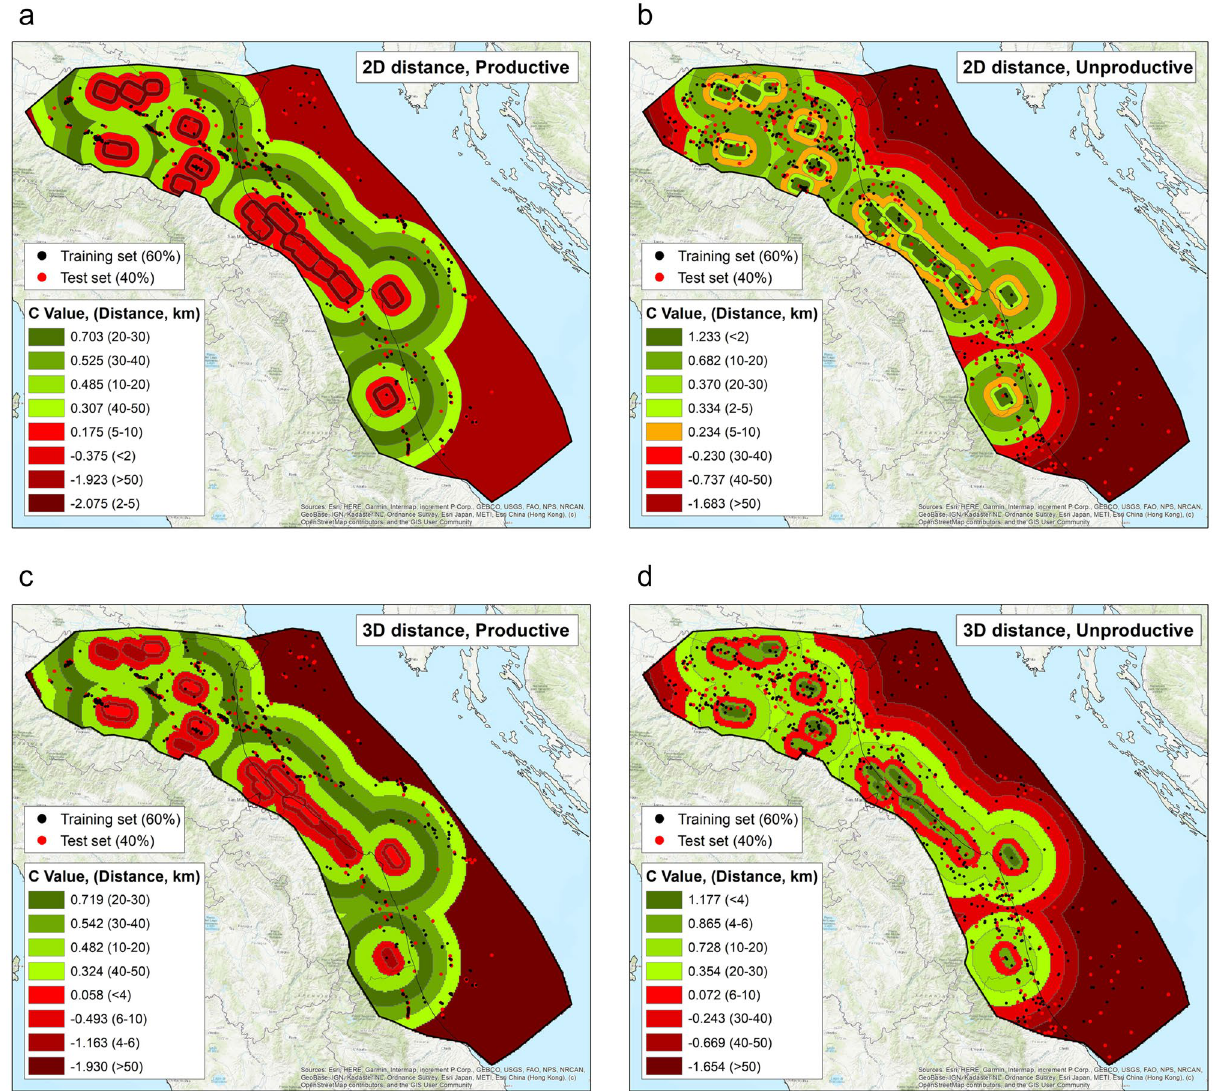
Figure 2. Distribution of C values for the 2D and 3D distance cases. Distribution of C values for the 2D ( a , b ) and 3D ( c , d ) distance cases, for productive (left) and unproductive wells (right), respectively. The figure was drawn using ArcGis 10.4.1 for Desktop/ArcMap 10.4.1.5686 by ESRI (http:// www. esri. In marked contrast, for unproductive wells the largest C values (1.233) and the largest Studentised contrast (9.077) are found for the first distance bin (0–2 km). C drops quickly for increasing distance ranges, becoming negative (− 1.683: C/S(C) − 9.847) for a distance > 50 km. These results indicate that the wells falling very close to a seismogenic fault are likely to be unproductive. 3D distances. Table 2b and Fig. 2c, d summarise the results obtained using the training dataset for the eight adopted distance bins in the 3D case. The results we obtained for productive wells indicate a non-significant correlation (C = 0.058) for the shortest distance bin (< 4 km); the ratio between the contrast weight and the standard deviation (0.180) for the closest bin of the 3D distances, however, indicates that an interpretation of the results should not be attempted. C is negative in the 4–6 km and 6–10 km bins (− 1.163 and − 0.493) and becomes positive C for distances > 10 km, implying that productive wells are generally drilled > 10 km from seismogenic faults. For distances > 50 km we found a negative C (− 1.930), as in the 2D case. The results suggest no statistical correlation, or a negative correlation, between the location of the productive wells and that of seismogenic faults. As for unproductive wells, the largest C (1.177) is found for the shortest distance bin (< 4 km). C then decreases up to a 10 km distance, increases again in the distance range 10–20 km, and drops beyond 50 km, becoming fully negative.